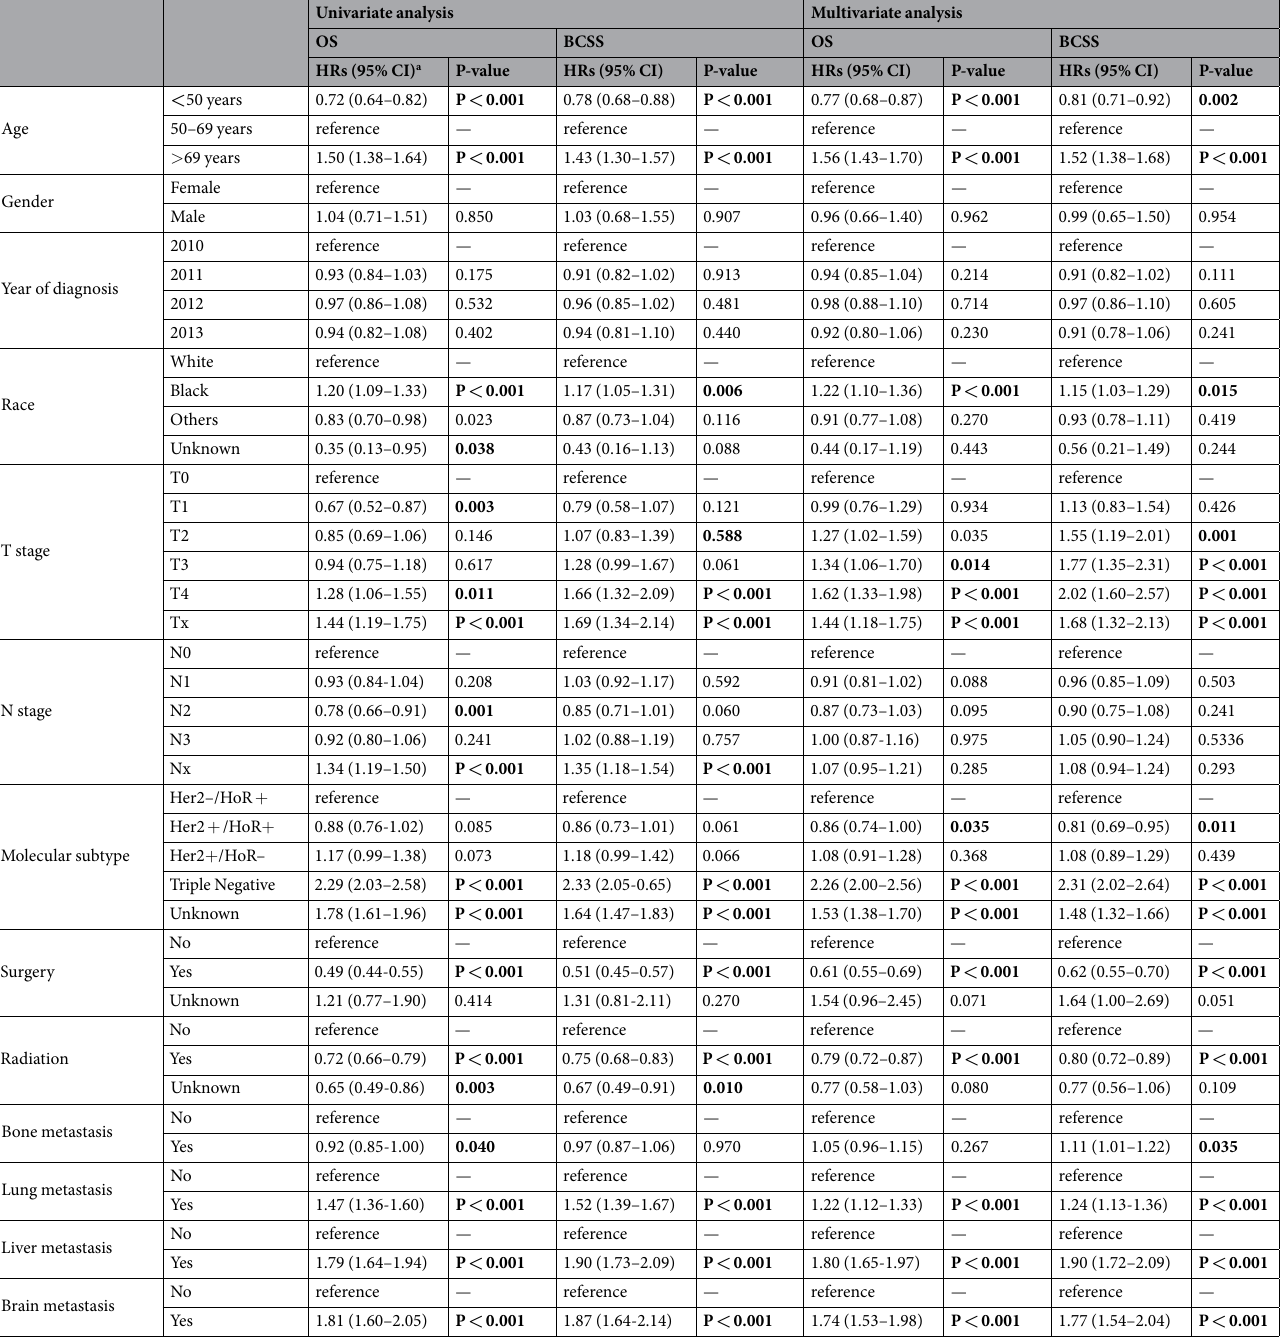
Table 3. Univariate and multivariate analysis of overall survival (OS) and breast cancer-specific survival (BCSS) of the study population. a HRs: hazard ratios; CI: confidence